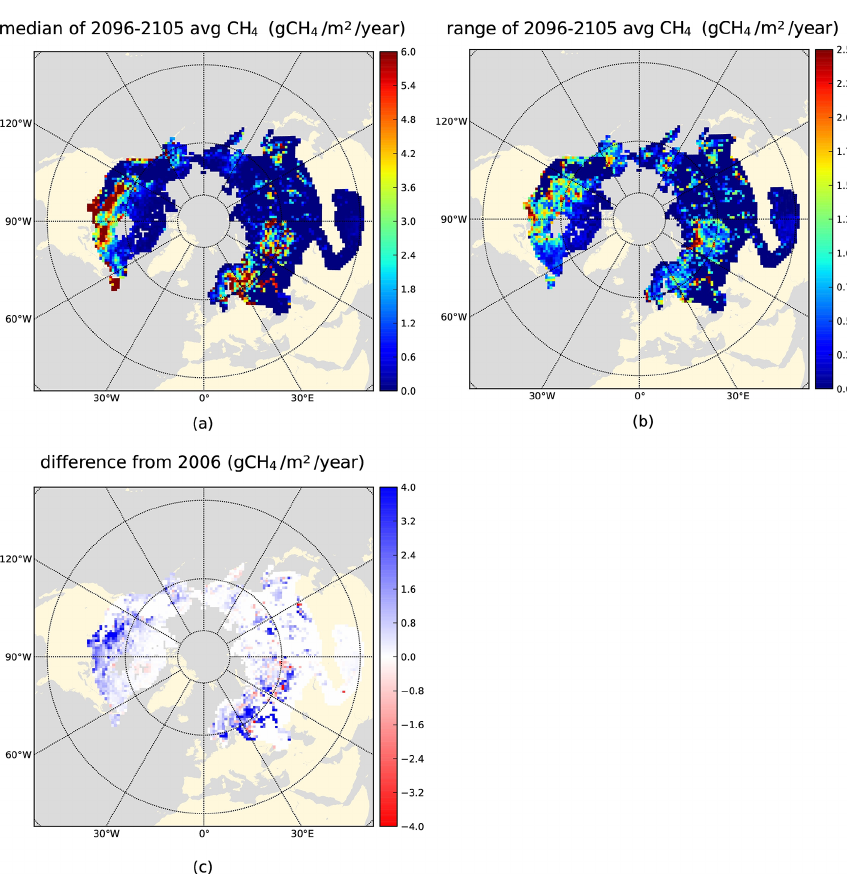
Figure 11. Ensemble median (a) and range (b) of average annual end-of-century (2096–2105) CH 4 emissions for the sensitivity-based projection and the difference between the median and the annual emissions of year 2006 (c) .